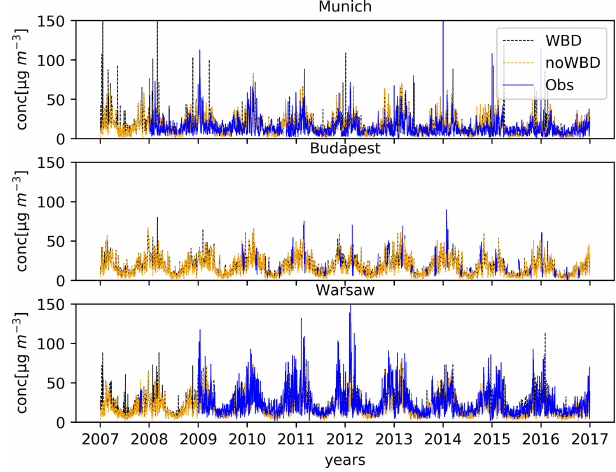
Figure 10. Averaged daily PM 2 . 5 concentrations of WBD (dashed black lines), noWBD (dashed orange lines) and the AirBase dataset (solid blue lines) for 2007–2016 (Vienna, Prague, Berlin). Units are micrograms per cubic metre.